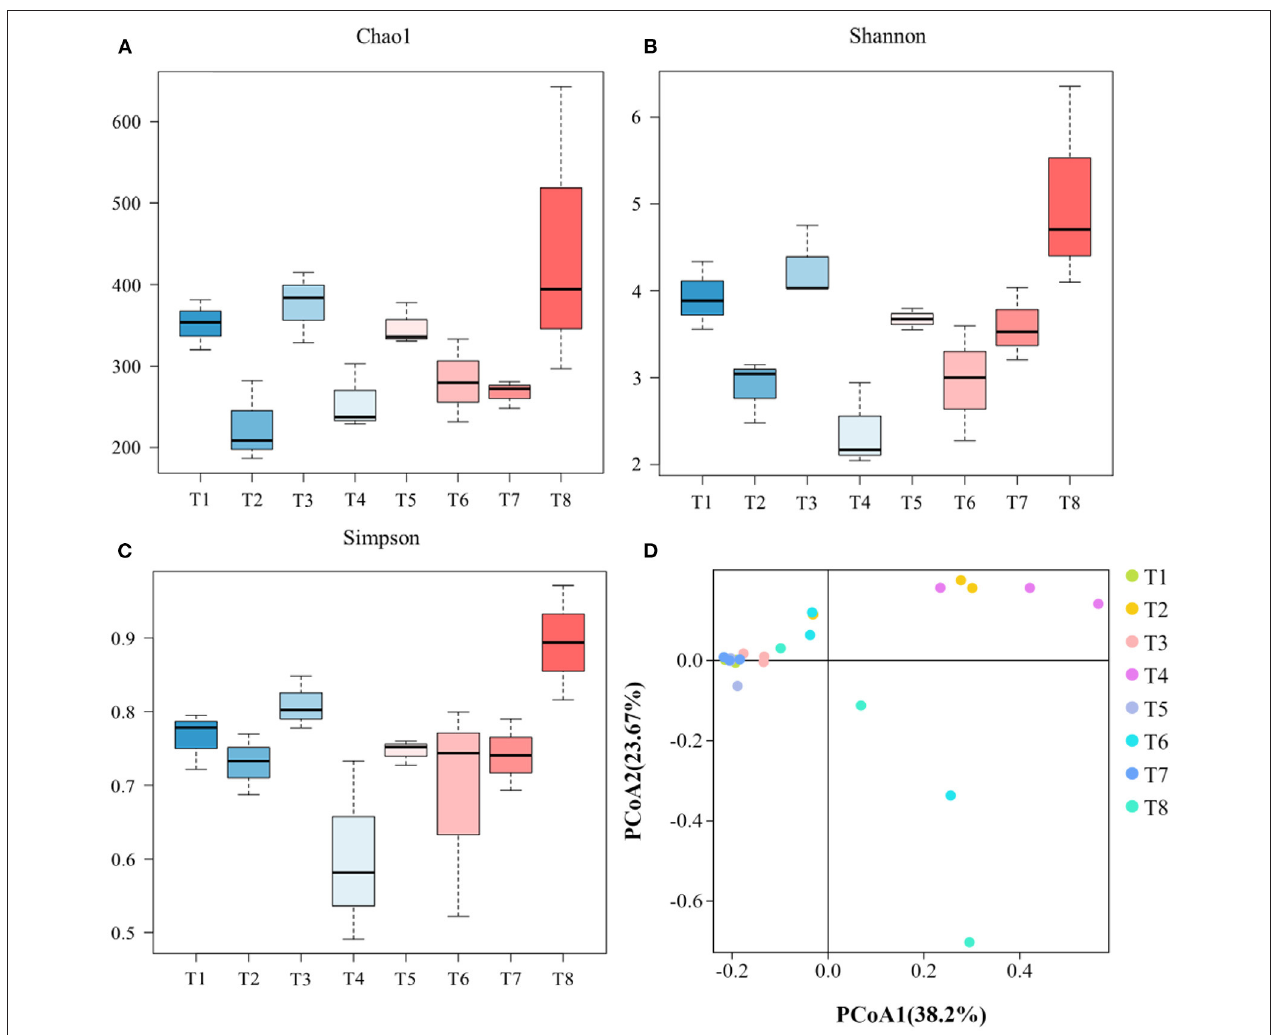
FIGURE 2 | Representing microbial diversity indices of Chao 1 (A) , Shannon (B) , and Simpson (C) and principal coordinate analysis of gut microbiome (D) . [T1 (DO 6mg L − 1 × pH 8.1 × 20 ◦ C), T2 (DO 6mg L − 1 × pH 8.1 × 30 ◦ C), T3 (DO 6mg L − 1 × pH 7.7 × 20 ◦ C), T4 (DO 6mg L − 1 × pH 7.7 × 30 ◦ C), T5 (DO 2mg L − 1 × pH 7.7 × 20 ◦ C), T6 (DO 2mg L − 1 × pH 7.7 × 30 ◦ C), T7 (DO 2mg L − 1 × pH 8.1 × 20 ◦ C), T8 (DO 2mg L − 1 × pH 8.1 × 30 ◦